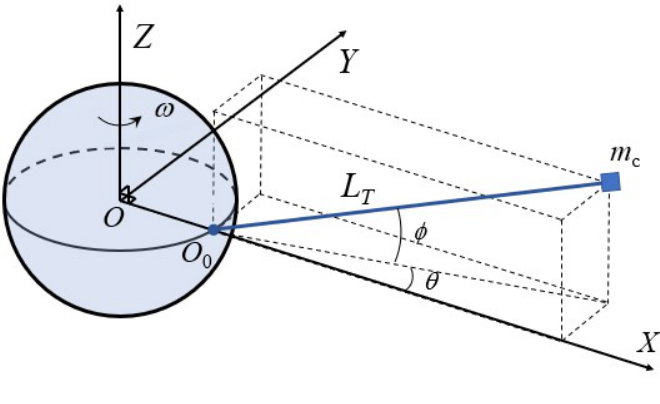
Figure 1. Space elevator system model.